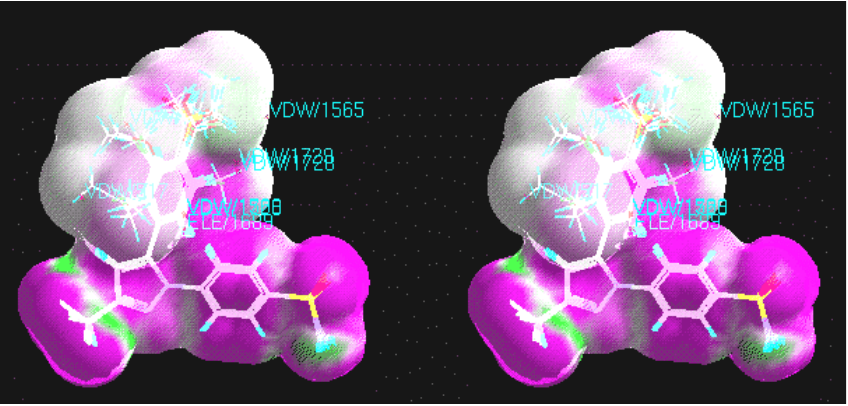
Figure 5. Stereoview of the receptor surface with all molecules considered and weights based on bio- logical activities. Interaction energies of individual molecules on the receptor surface are coloured (violet for a favourable interaction and green for an unfavourable one). The grid points involved in the final QSAR equation are labelled which mainly originates from different substituted phenyl ring which is neither violet nor green indicating substitution maneuvering is possible there without significant loss of biological